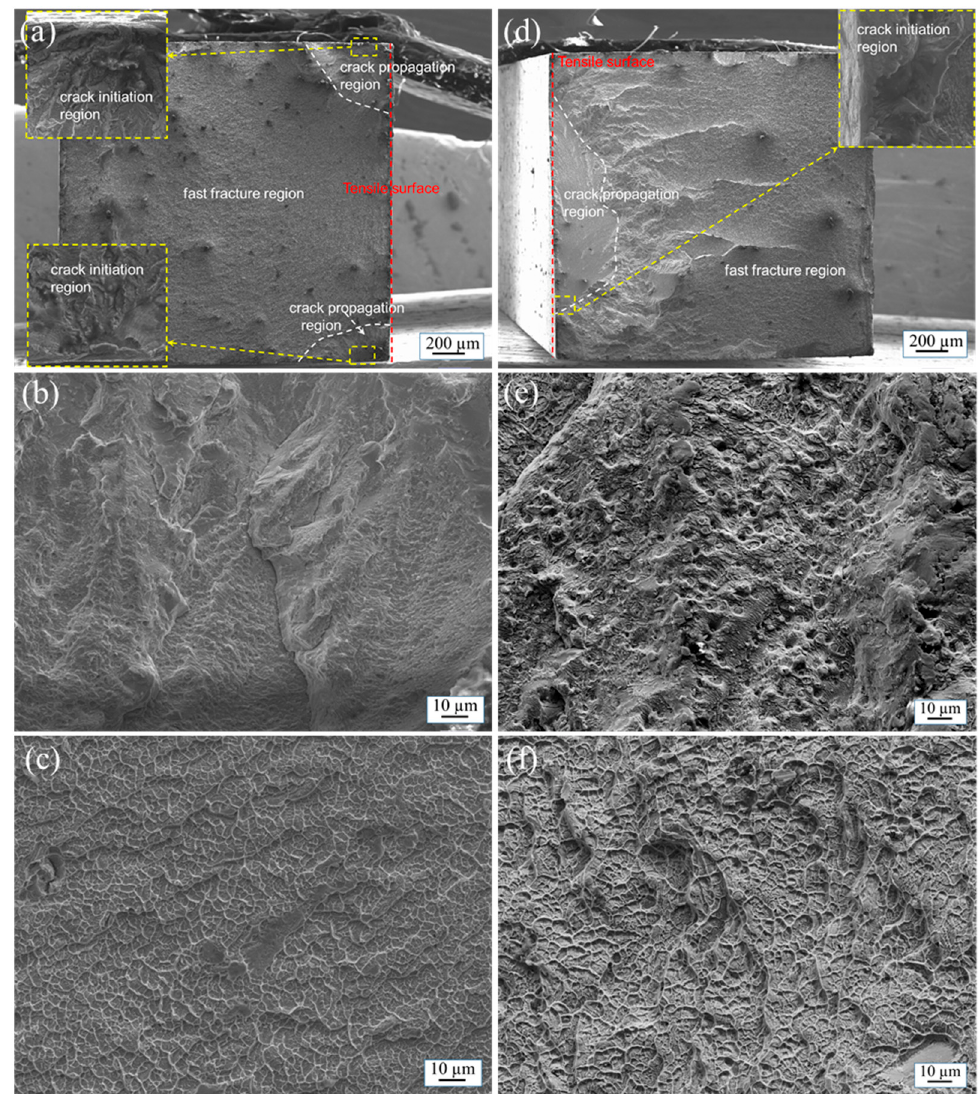
Figure 5. Fatigue fractography of our bulk metallic glass (BMG) tested at σ max = 800 MPa after N f = 24,369 as shown in ( a – c ) and σ max = 400 MPa after N f = 805,992 as shown in ( d – f ). ( a , d ) show over fatigue fractography and magnification images of crack initiation region; ( b , e , c , f ) show magnification images of crack propagation region and fast fracture region, respectively.